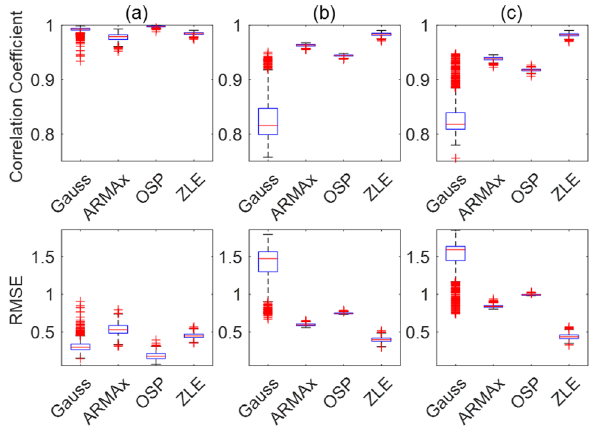
x x R − f and filtered R − f (simulated RR: ( a ) (cid:31)